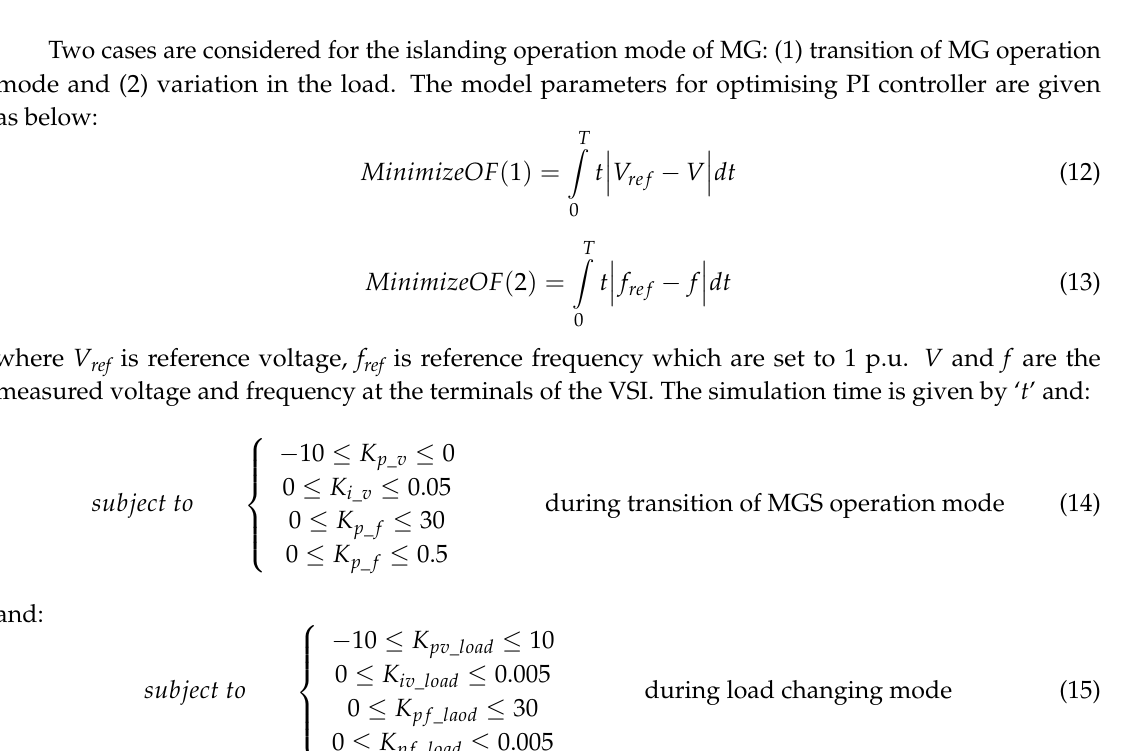
Figure 4. Proposed controller incorporating